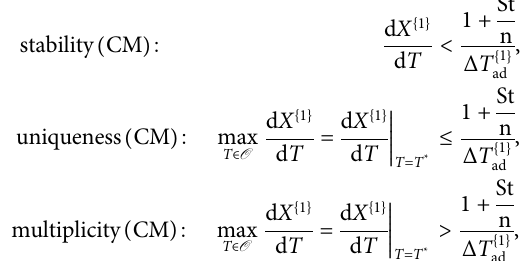
Frontiers in Energy Research |